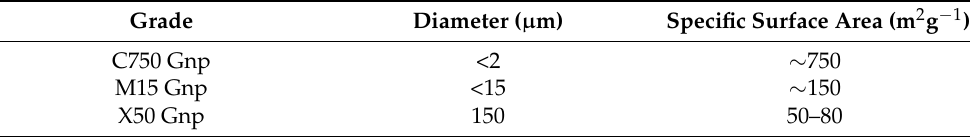
Table 1. Physical properties of commercialized Gnps used in this